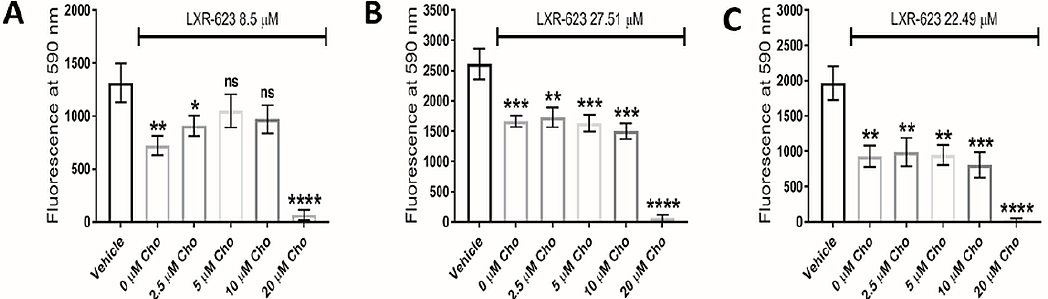
Figure 6. Dependence of LXR-623 on cholesterol export for therapeutic efficacy. ( A – C ) Cellular viability of U373, KNS42 and SF188 glioma cells, respectively, treated with LXR-623 for 72 h in the